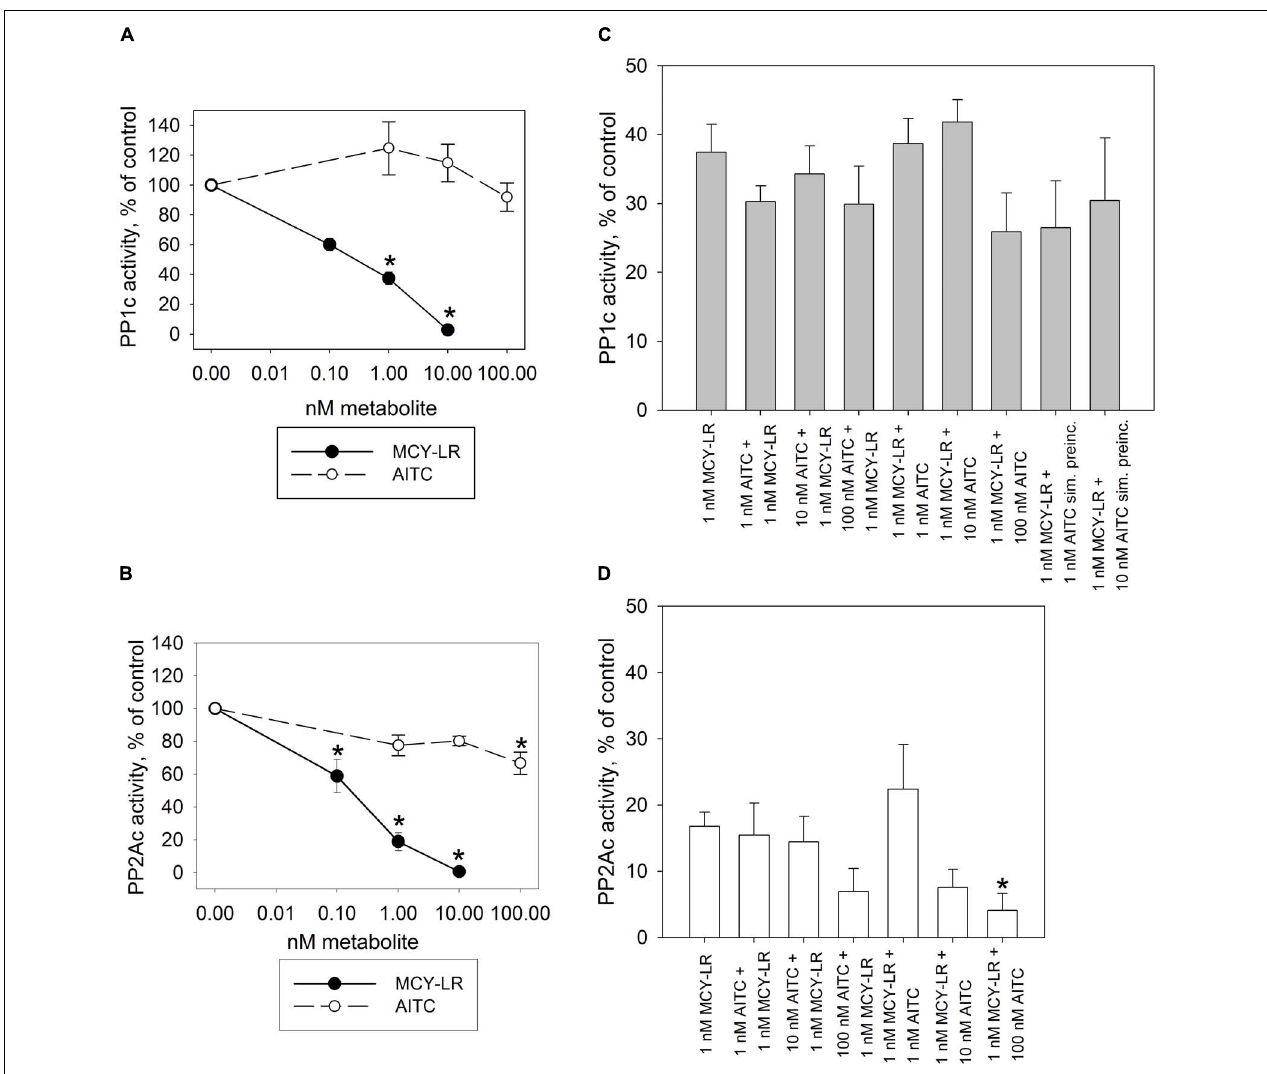
FIGURE 4 | Effects of AITC and MCY-LR on PP1c (A,C) and PP2Ac (B–D) activities in vitro . (A,B) Effects of single metabolites in the percentage of control (no treatment) (100%). (C,D) Effects of AITC + MCY-LR combinations as compared to the treatment with 1 µ M MCY-LR. Activities are expressed here as the percentages of controls (no treatment, 100%) but the statistical significance of the differences between single MCY-LR and combined treatments were analyzed as well. When the combinations of the two compounds were used, preincubation (see Materials and Methods) was started with the compound named firstly. “sim. preinc” means that the two compounds were preincubated simultaneously. PP1c and PP2Ac refers to the catalytic subunits of the protein phosphatases. ∗ Significant differences of treatments to controls ( P < 0.05), n ≥